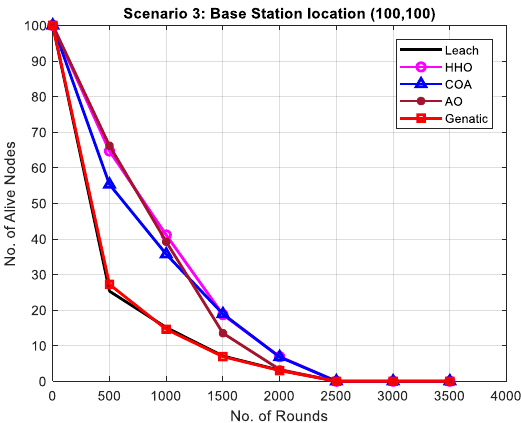
Figure 4. Number of alive nodes in case of scenario 2: BS at (50,50).